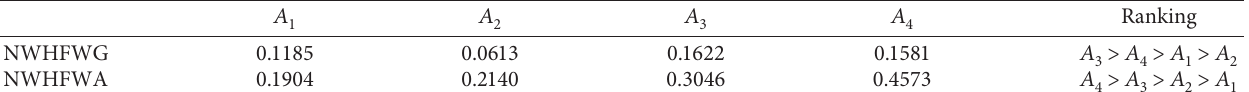
Table 9: The decision results of the different